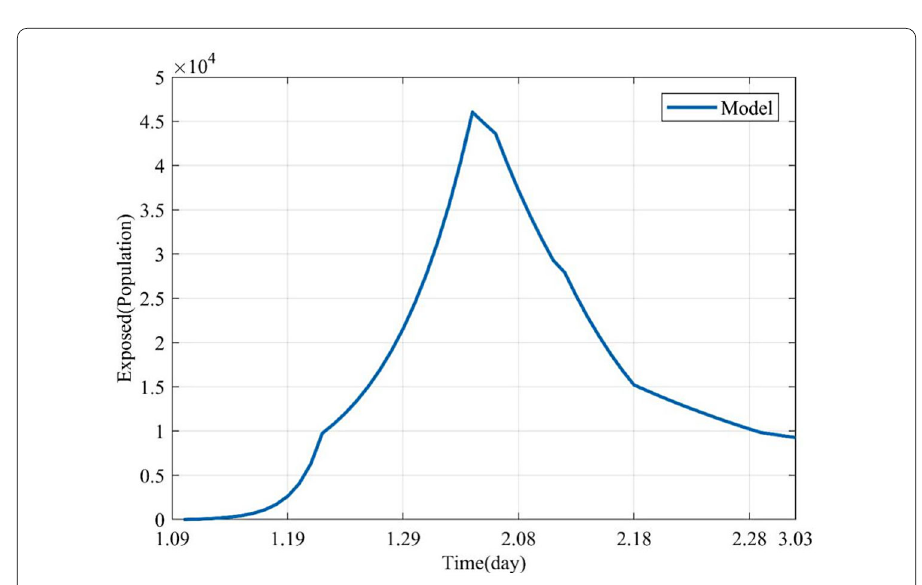
Figure 3 Dynamic trends of the exposed